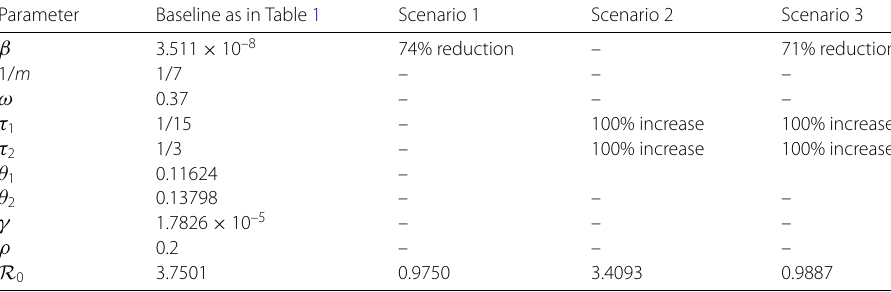
Table 2 Assessing the basic reproduction number, R 0 Parameter Baseline as in Table